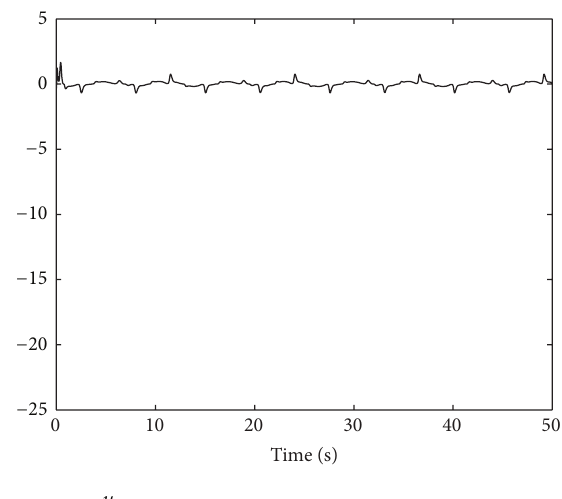
Figure 1: System output 𝑦 and reference signal 𝑦 𝑑 .